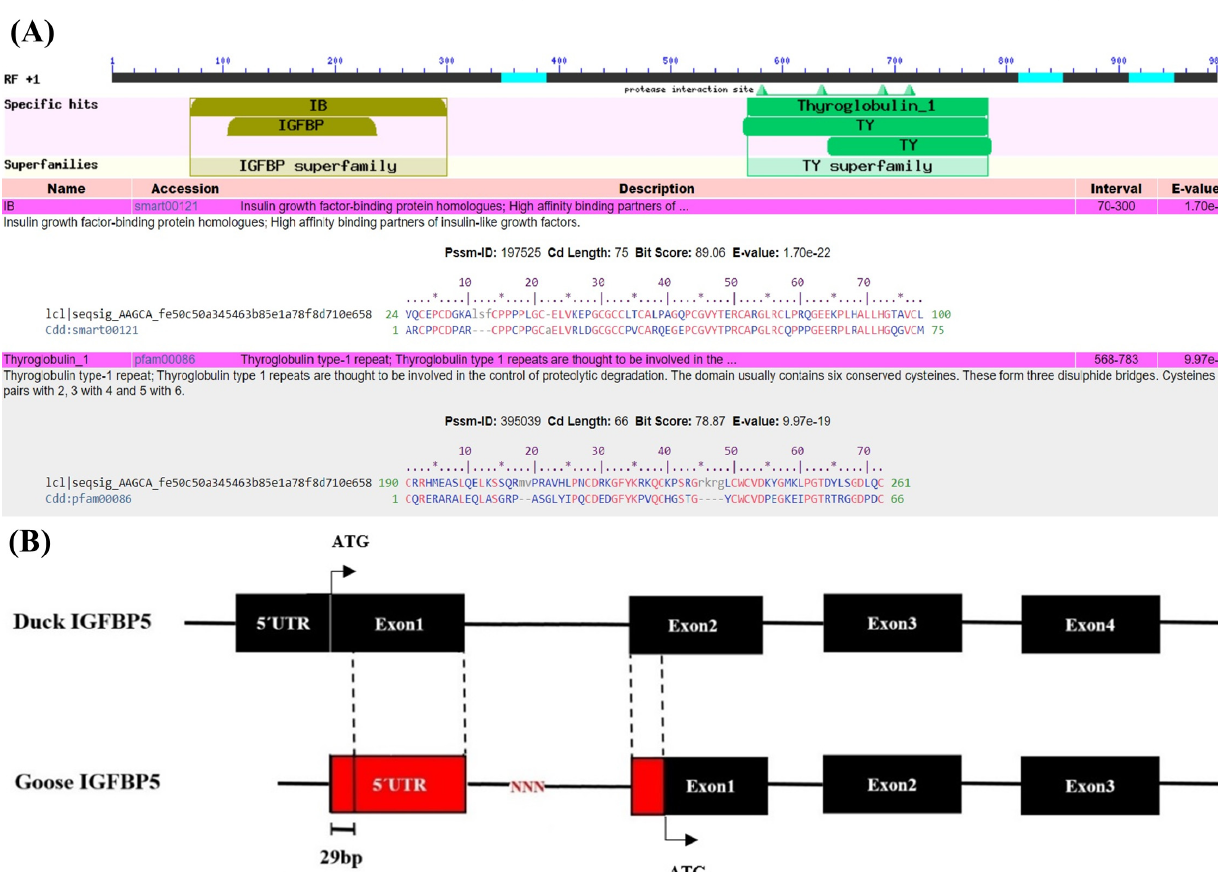
Figure 3. The predicted functional domains of the goose IGFBP5 protein ( A ) and the structural alignment of the goose IGFBP5 sequence against the duck IGFBP5 sequence ( B ). ( A ) The